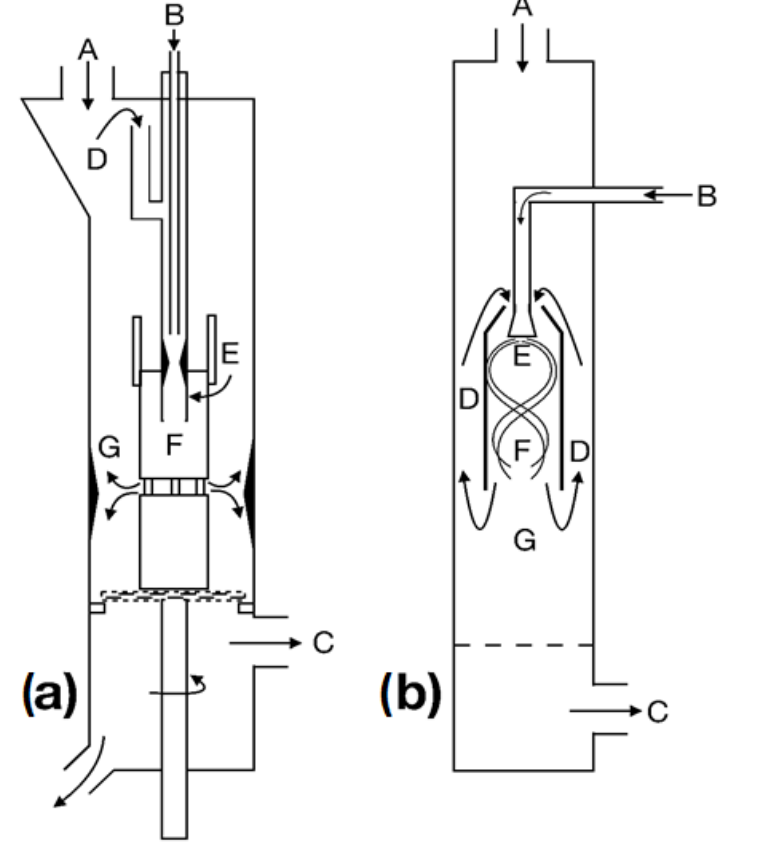
Figure 4. ( a ) Susanto–Beenackers gasifier (adapted from [78]); ( b ) Rahman et al. LTB gasifier (adapted from [79]).